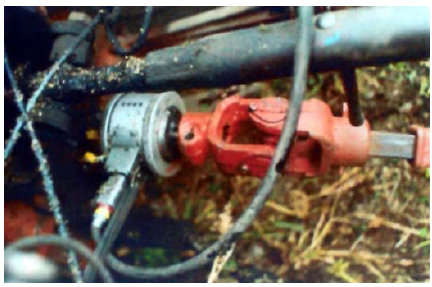
Figure 3. Required torque and power sensor arranged at the tractor power take ‐ off (PTO).